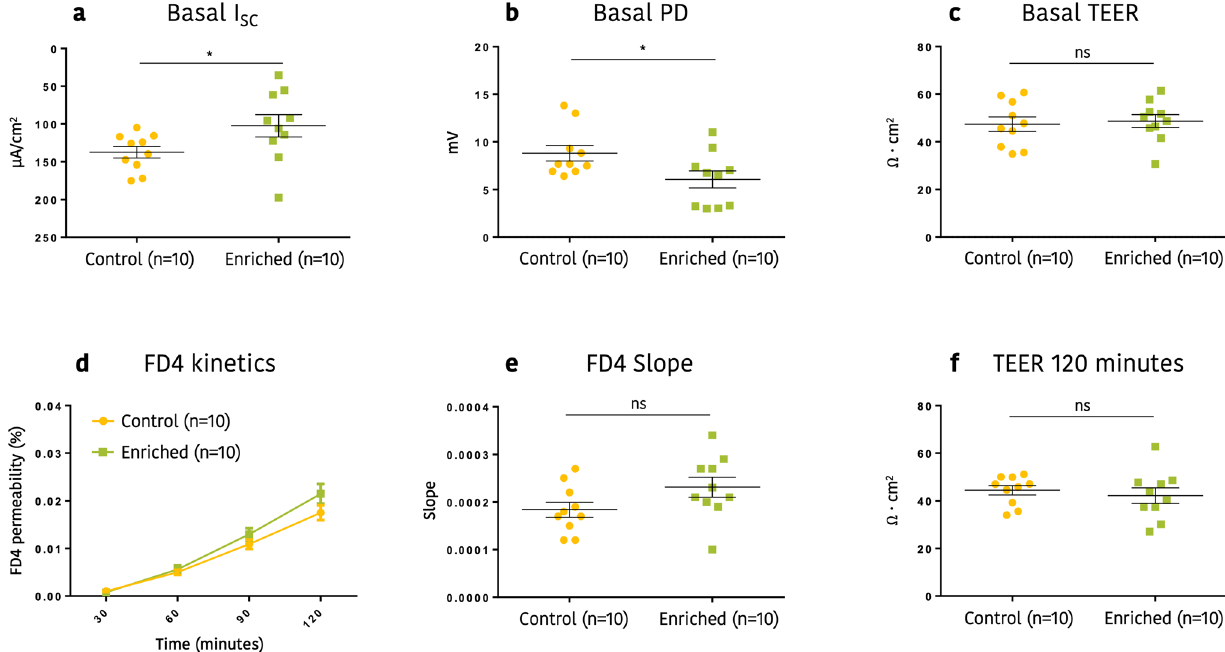
Figure 4. Effect of early socialization and environmental enrichment on transepithelial ion transport paracellular permeability to fluorescent tracers at day 3 post weaning. ( a ) Basal colonic I sc , ( b ) Basal colonic PD, ( c ) Basal colonic TEER, ( d ) FD4 flux, ( e ) FD4 slope and ( f ) TEER at 120